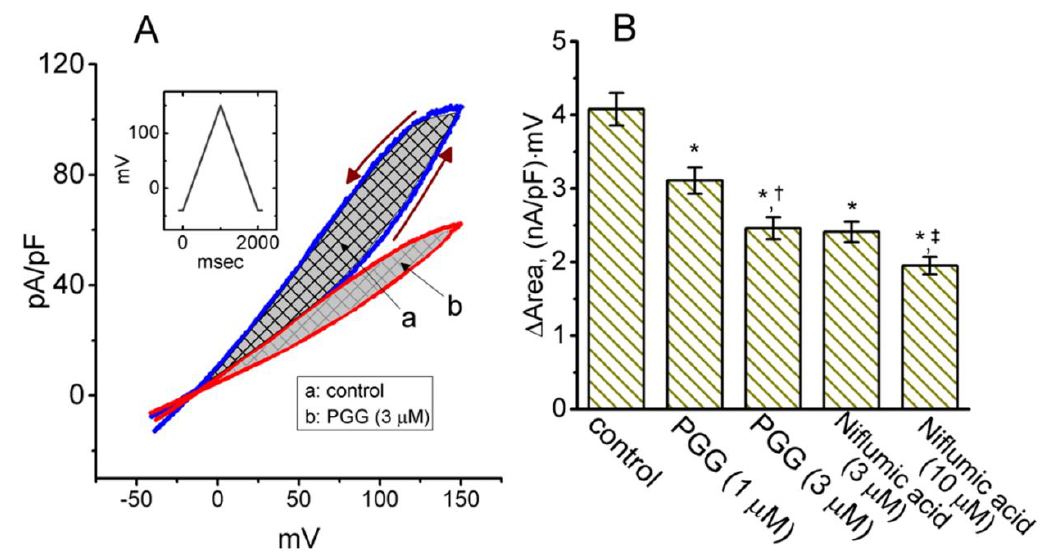
Figure 6. E ff ect of PGG on the voltage-dependent hysteresis of I PAC density identified from GH 3 cells. Cells were bathed in acidic (pH = 7.4), Ca 2 + -free Tyrode’s solution. ( A ) Representative I PAC density in the absence (a) or presence (b) of 3 µ M PGG. Current densities were elicited in response to 2-sec long isosceles-triangular ramp voltage command (indicated in the Inset). The arrows denote the direction of I PAC density in which time passes. ( B ) Summary bar graph showing the e ff ect of PGG (1 or 3 µ M) or niflumic acid (3 or 10 µ M) on the ∆ area (indicated in the shaded area of ( A )) of the voltage hysteresis (mean ± SEM; n = 8 for each bar). The statistical analyses were done by ANOVA-1, p < 0.05, followed by a post-hoc Fisher’s least-significant di ff erence test, p < 0.05. * indicates a significant di ff erence from control ( p < 0.05), † indicates significant di ff erence from the PGG (1 µ M)-alone group ( p < 0.05), and ‡ indicates a significant di ff erence from the niflumic acid (3 µ M)-alone group ( p <